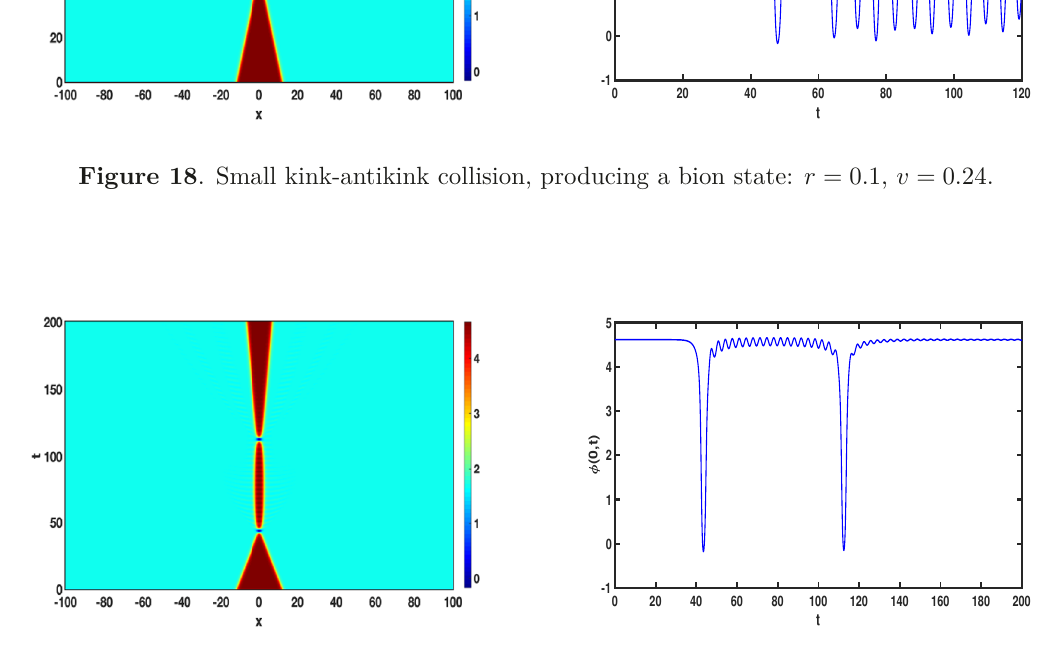
Figure 19 . Small kink-antikink collision, showing two bounces: r = 0 . 1, v = 0 . 267.